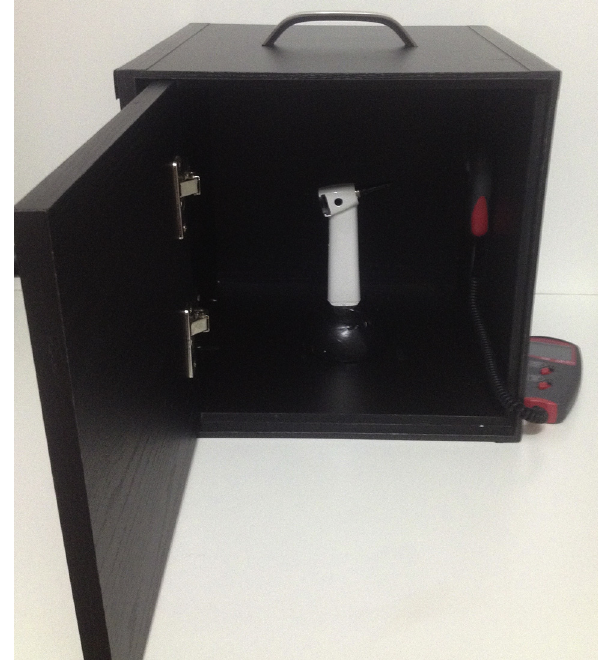
Figure 2 Otoscope fixed at the base at a 4-cm distance and light source directed to the central point of the